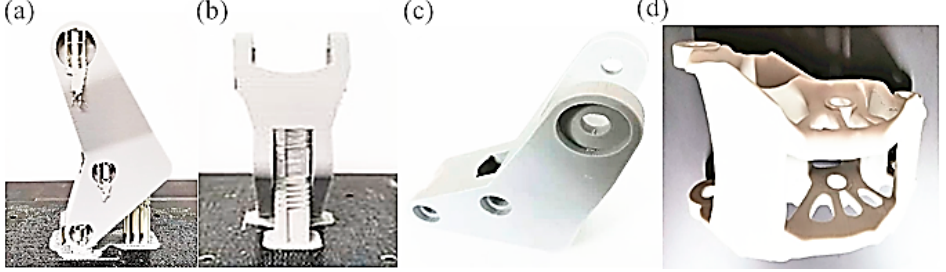
Figure 8. Printing effect: ( a ) Original model; ( b ) Topology optimization model: ( c ) Original model; and ( d ) Topology optimization model.